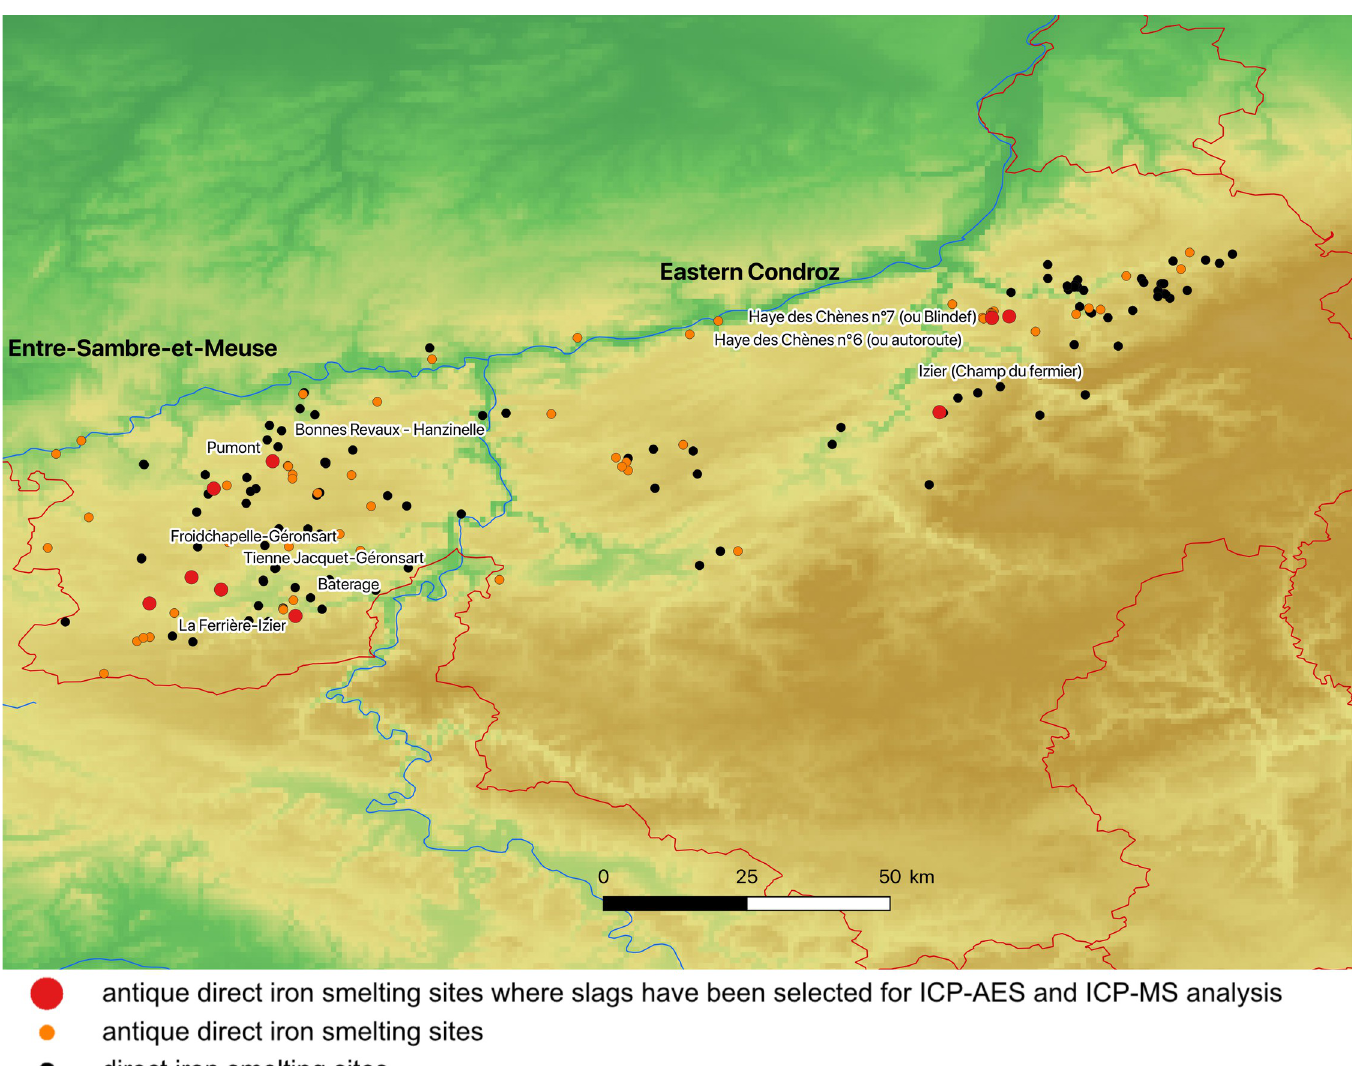
Fig 4. The Entre-Sambre-et-Meuse and Eastern Condroz iron production areas in Wallonia (Belgium, north at the top; DEM NASA Shuttle Radar Topography Mission Global 1 arc